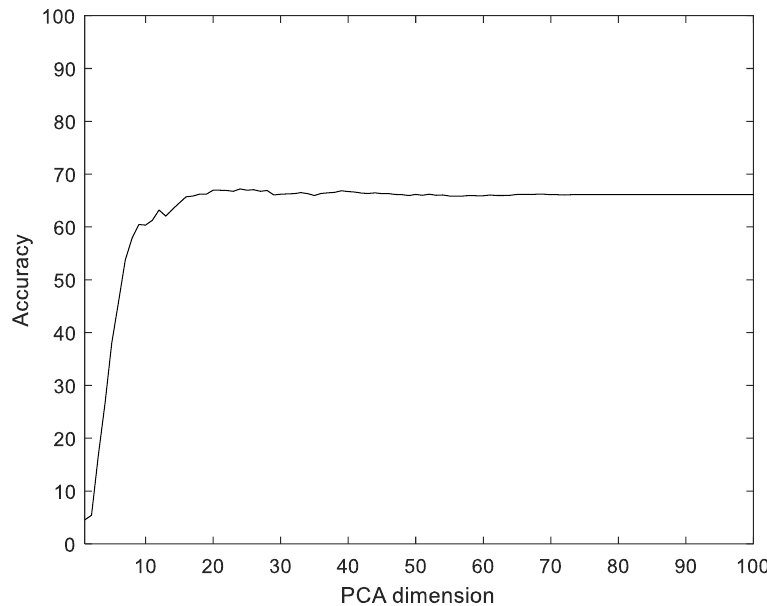
Figure 8. Recognition rate according to the dimension reductions by PCA on the Angeles EMG da-